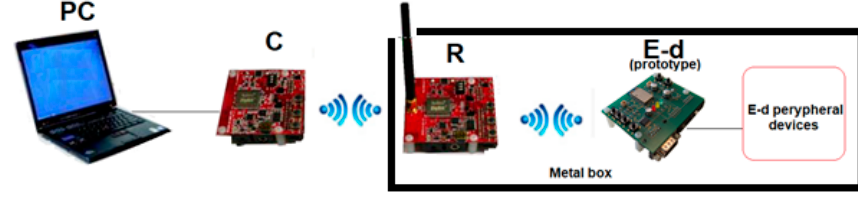
Figure 8. The ZigBee network testing setup.